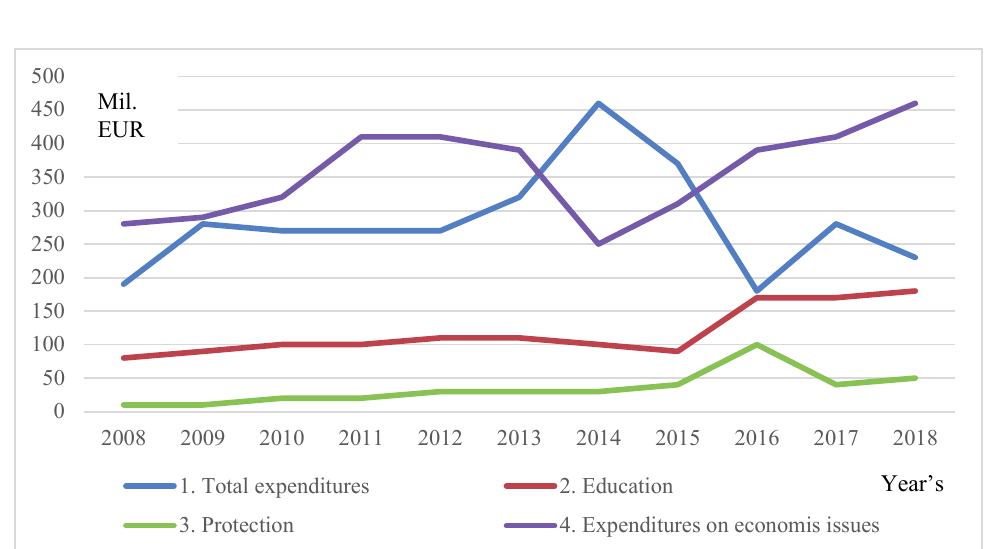
Fig. 6. Sectorial public expenditures in the Republic of Kosovo in 2008–2018 (Statistical Agency of